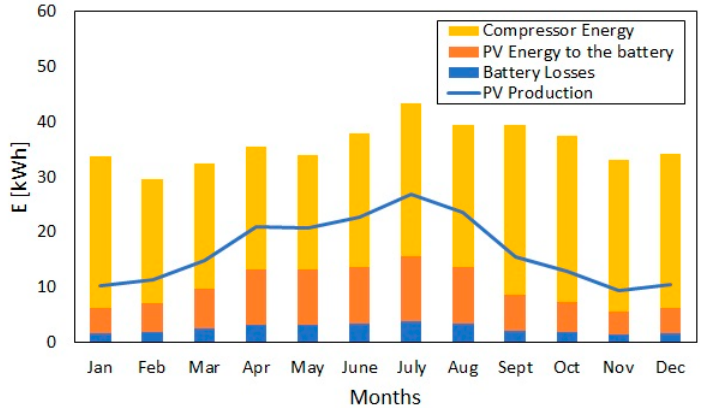
Figure 4. Monthly distribution of energy in the system: energy required to move the compressor of the refrigeration unit, energy produced by the PV panels and sent to the battery, battery losses, and total energy produced by the PV panels.